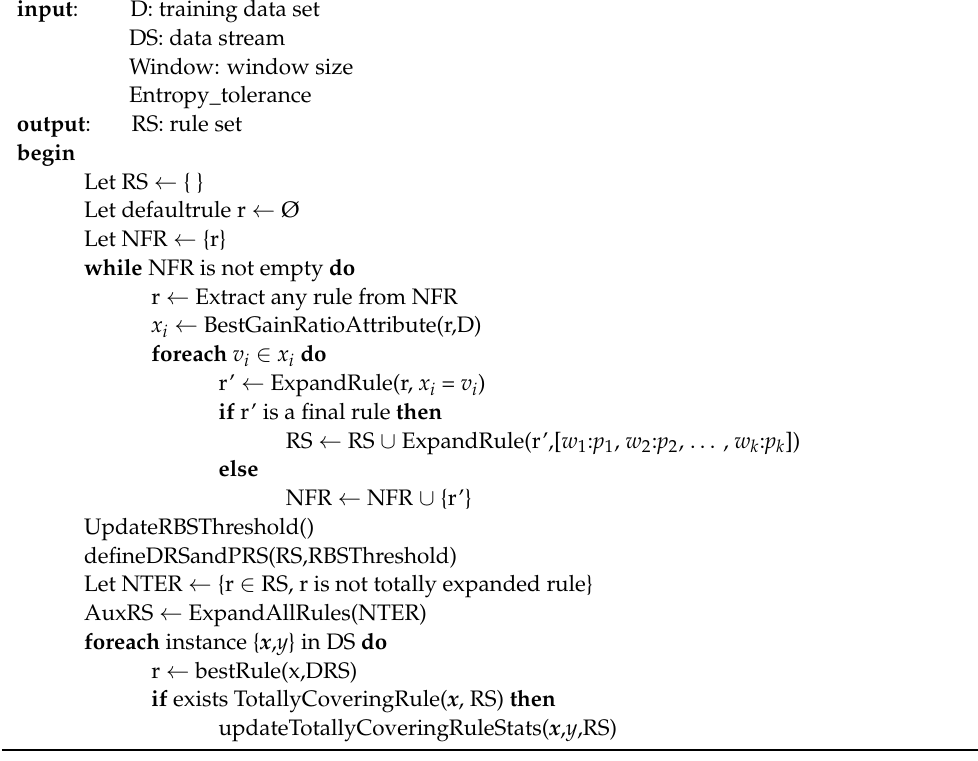
Algorithm 2: IDRA: Incremental Decision Rule